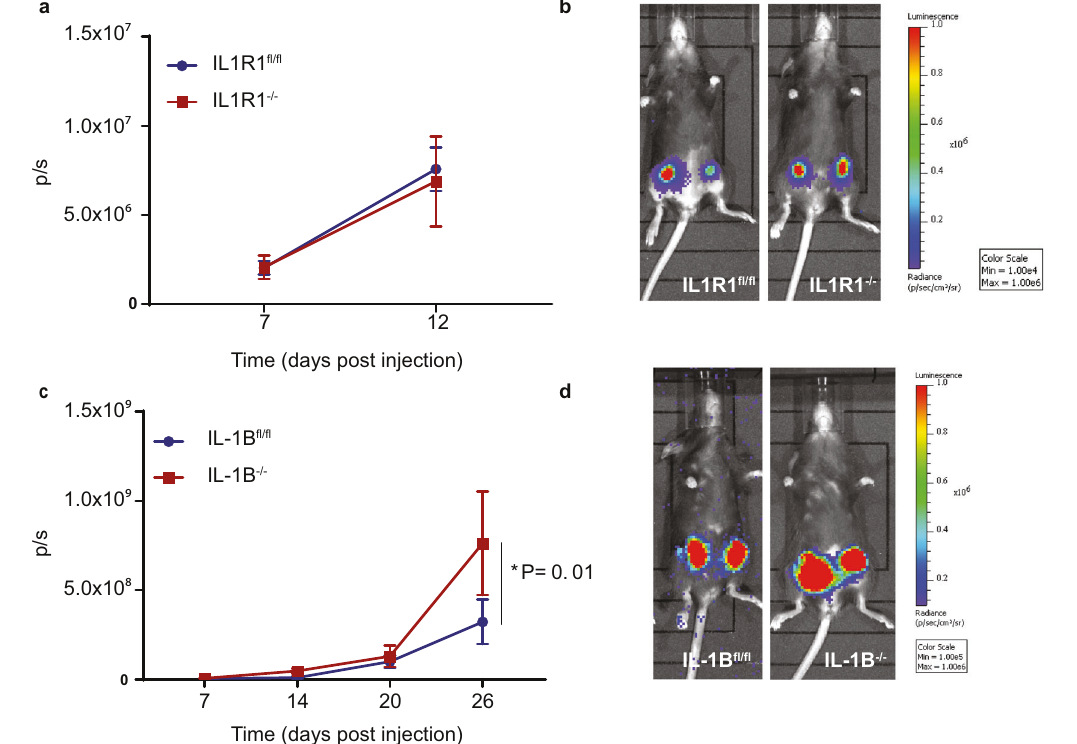
Fig. 1 Depletion of IL-1B but not IL1R1 from the microenvironment promotes primary tumour growth. a Quanti fi cation (photons/sec (p/s)) of primary tumour growth in IL1R1 fl / fl ( n = 8 primary tumours from n = 4 mice) and IL1R1 − / − ( n = 8 primary tumours from n = 4 mice) mice up to 12 days of post-orthotopic injection of E0771-luc2-V5-GFP cells and b correspondent micrographs. c Quanti fi cation (p/s) of primary tumour growth in IL-1B fl / fl ( n = 7) and IL-1B − / − ( n = 6) mice up to 26 days of post-orthotopic injection of E0771-luc2- GFP cells and d correspondent micrographs. IL-1B fl / fl : n = 13 primary tumours from n = 7 mice (day 7 and 14); n = 12 primary tumours from n = 6 mice (day 20 and 26). IL-1B − / − : n = 12 primary tumours from n = 6 mice (day 7); n = 10 primary tumours from n = 6 mice (day 14, 20, and 26). 2.3-fold increase in primary tumour growth in IL-1B − / − mice (7.6 × 10 8 p/s) compared to IL-1B fl / fl mice (3.2 × 10 8 p/s) ( P = 0.01). Data are mean + / − SEM, Two-way ANOVA with Sidak ’ s post-hoc